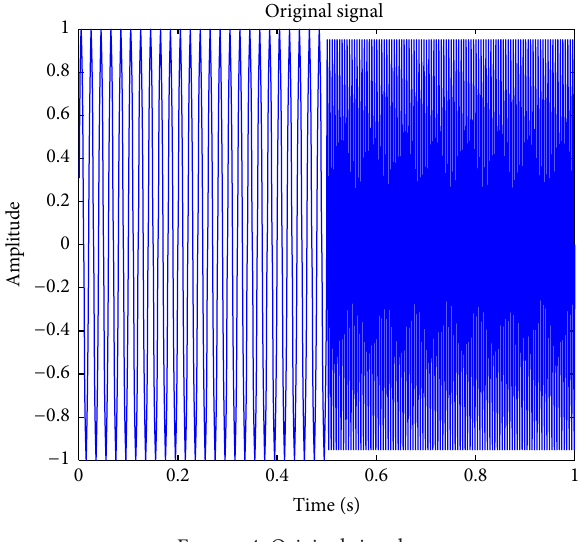
Figure 4: Original